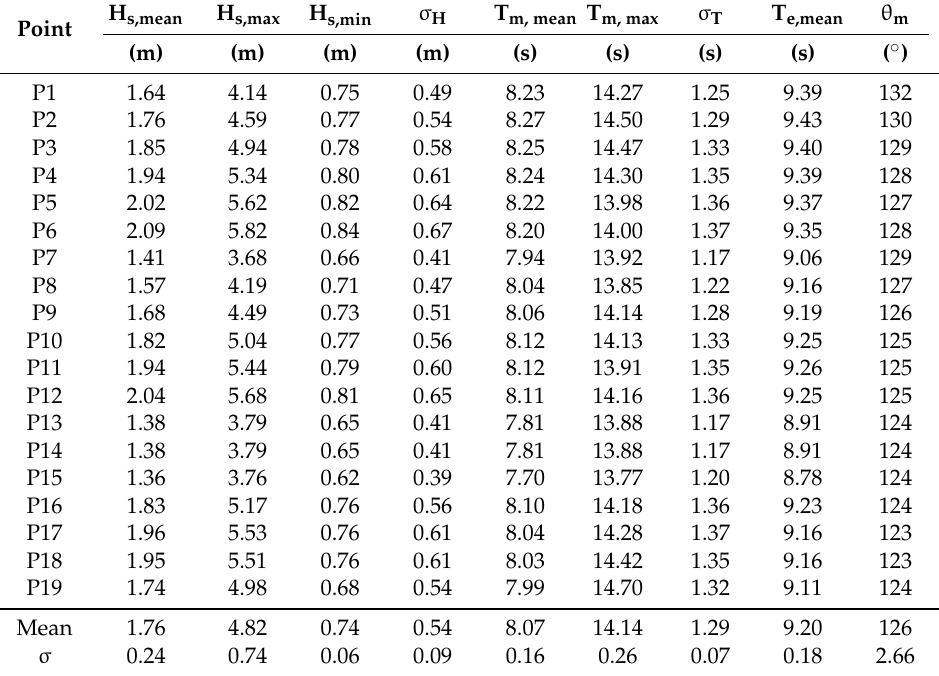
Table 2. Main wave climate parameters (based on 10-year average) at ECMWF grid